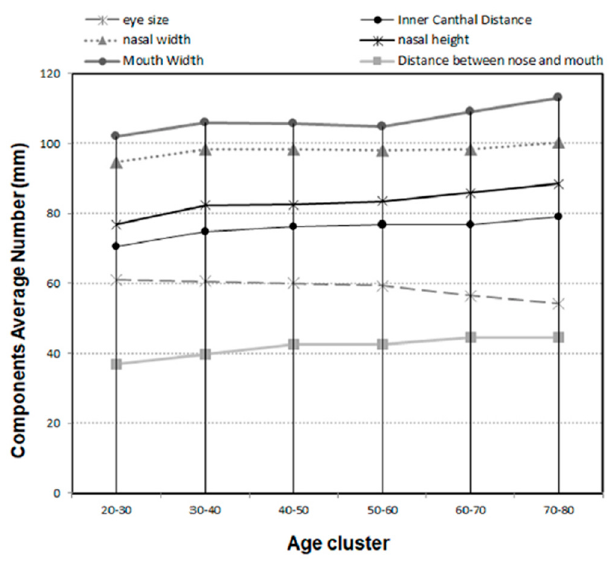
Figure 1. Facial components’ size and distance distribution.